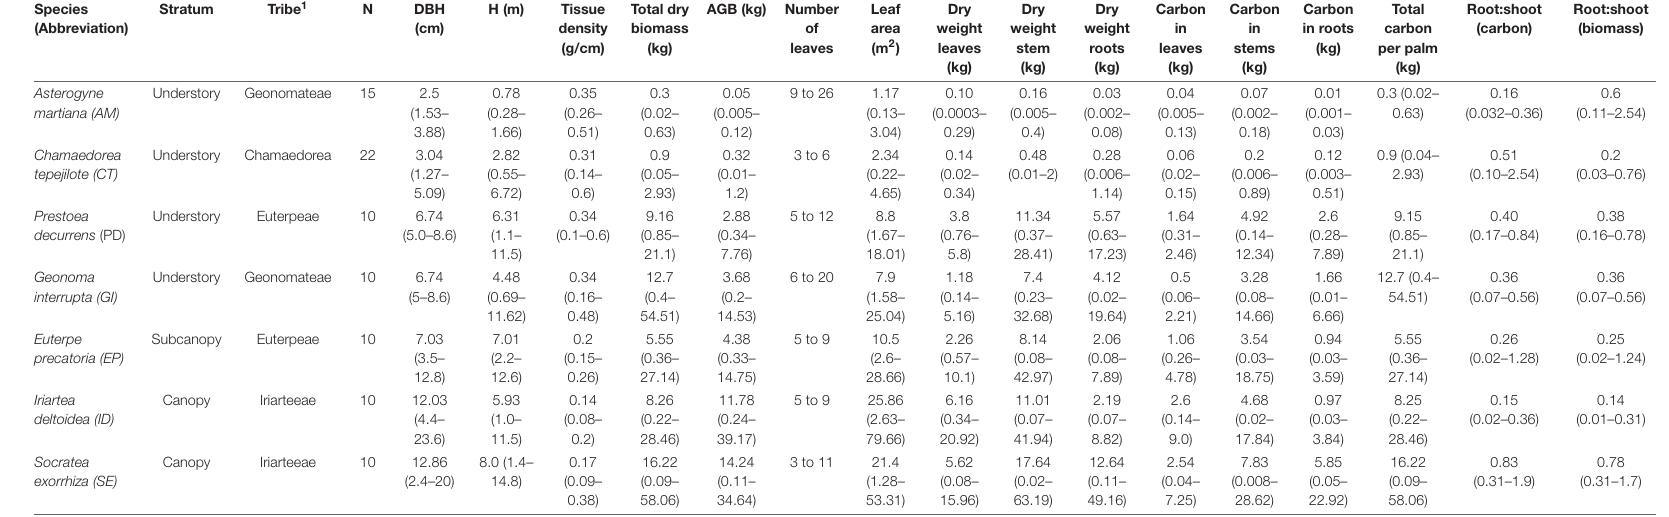
Values correspond to means (minimum-maximum values). 1 Follows Dransfield et al.